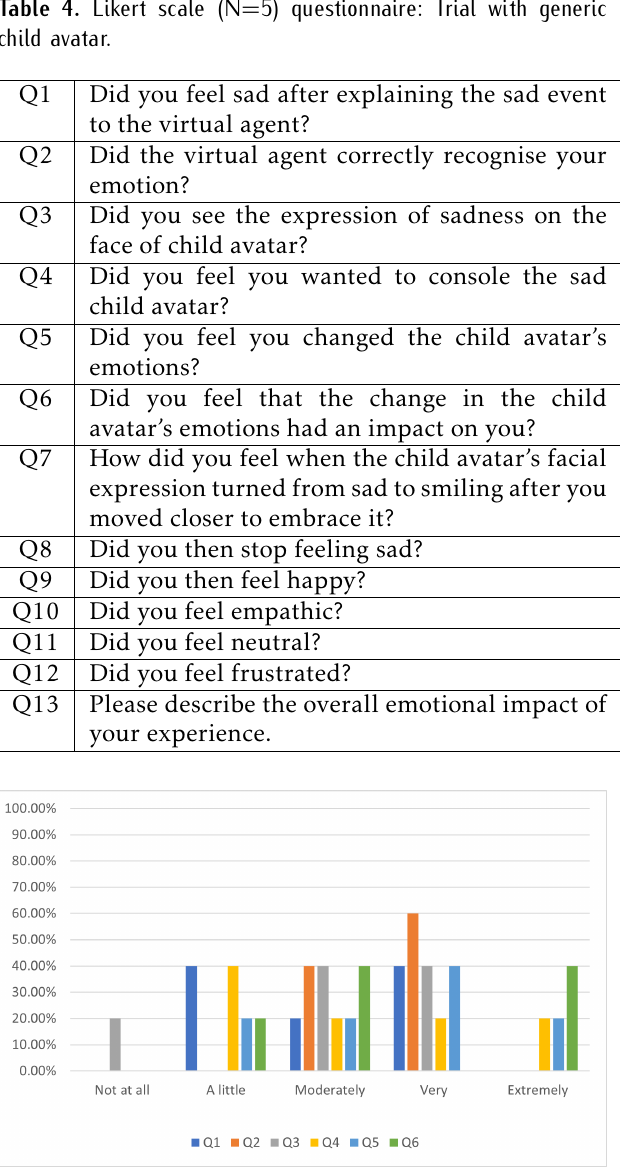
Figure 8. Overall percentage selection for questions Q1 to Q6 in Table 4. Table 5. Answers to Q7 in Table 4.